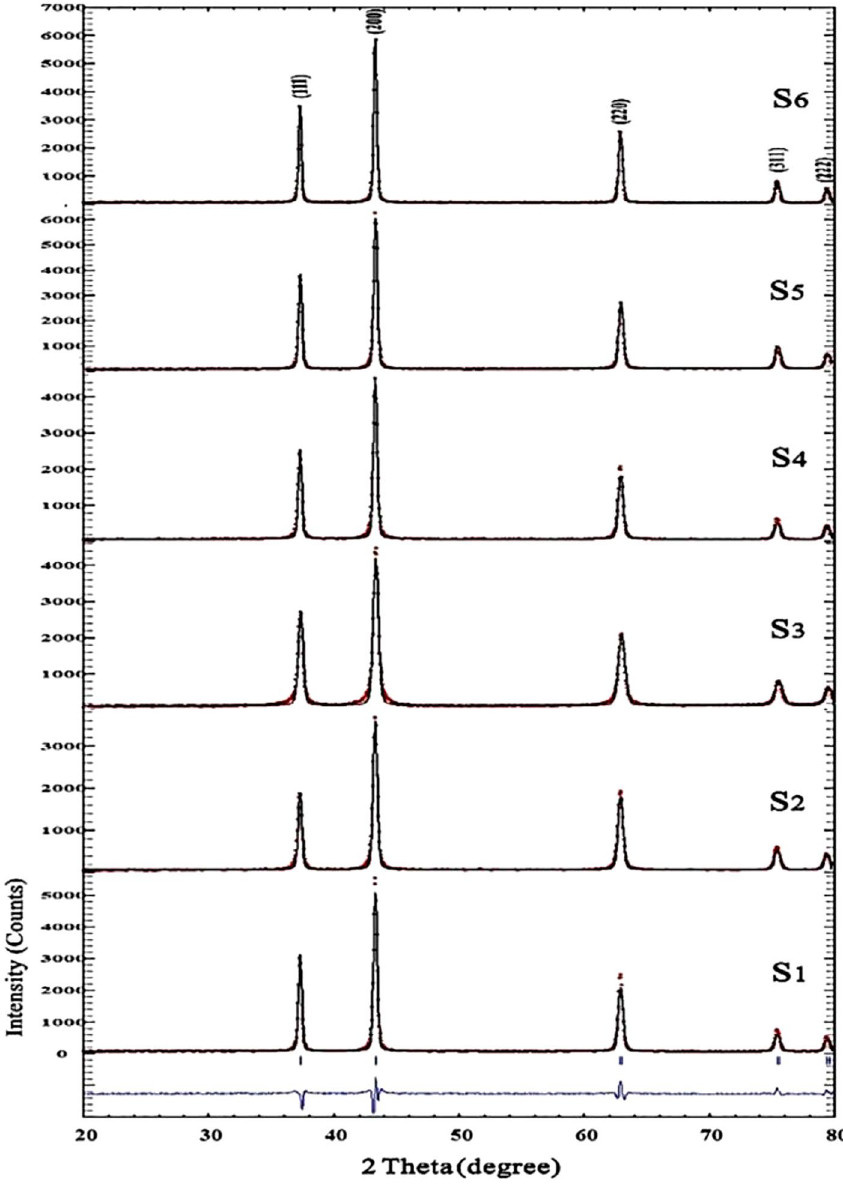
Figure 3. PXRD patterns of the NiO nanomaterials synthesized by hydrothermal method at 80 °C for 24 h followed by a calcination at 400 °C for 10 h refined by the Rietveld